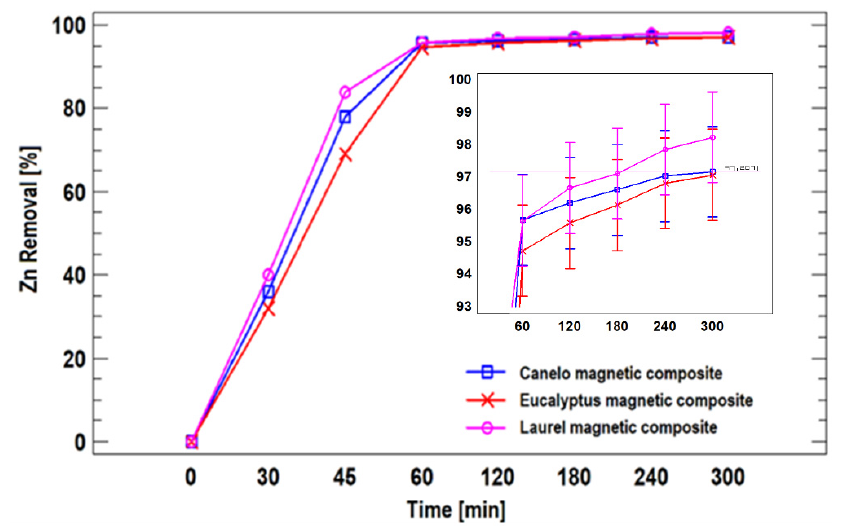
9 of 16 Figure 4. X-ray diffraction pattern of magnetite nanoparticles and magnetic composites. 3.2. Adsorption Studies